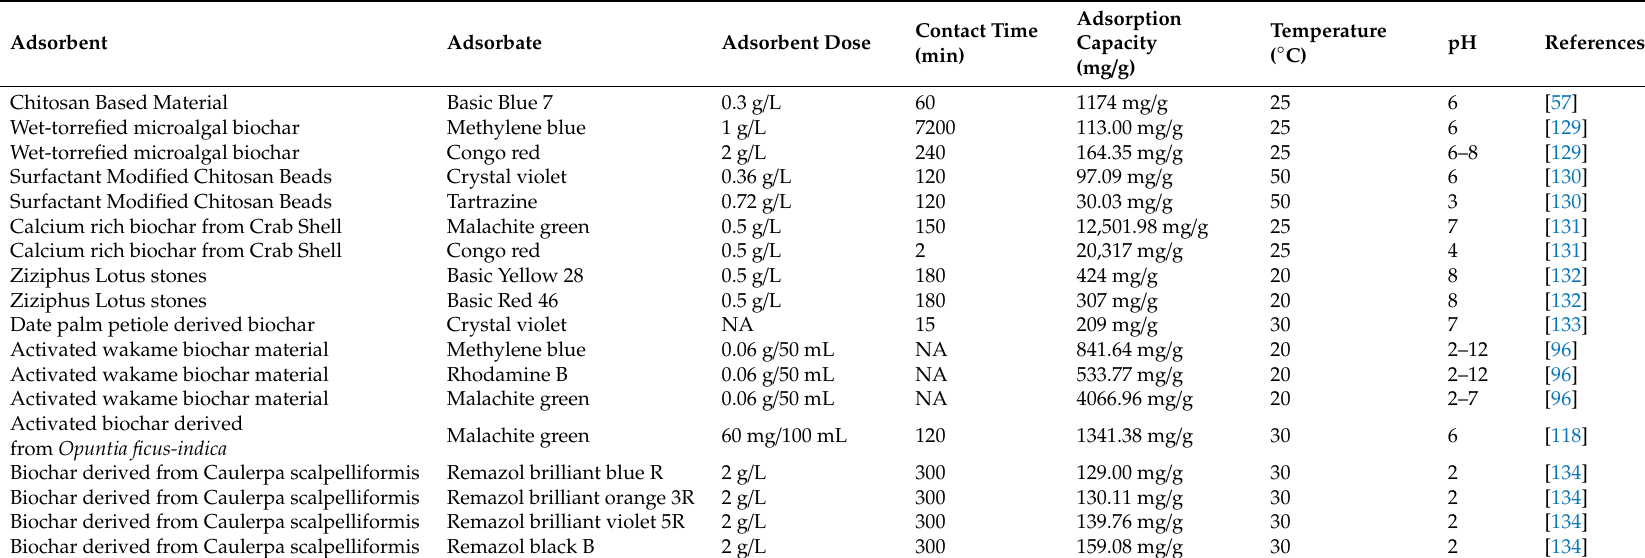
Table 4. Adsorption capacities of various biochar adsorbents for the removal of di ff erent dyes from